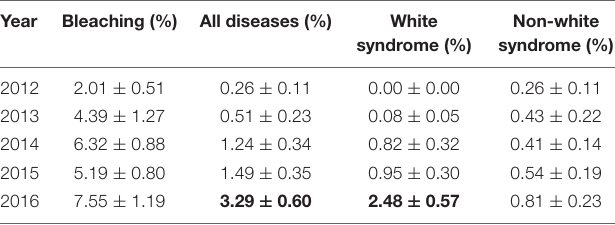
TABLE 2 | Mean ( ± SE) annual bleaching and disease